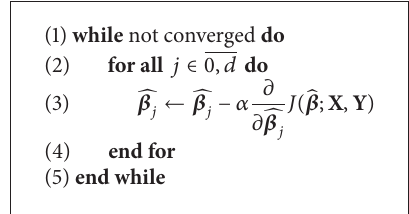
Algorithm 1: Stochastic Gradient Descent